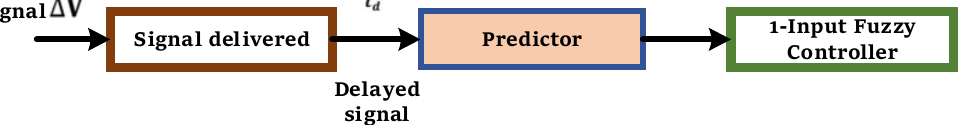
Figure 8. Predictor model.